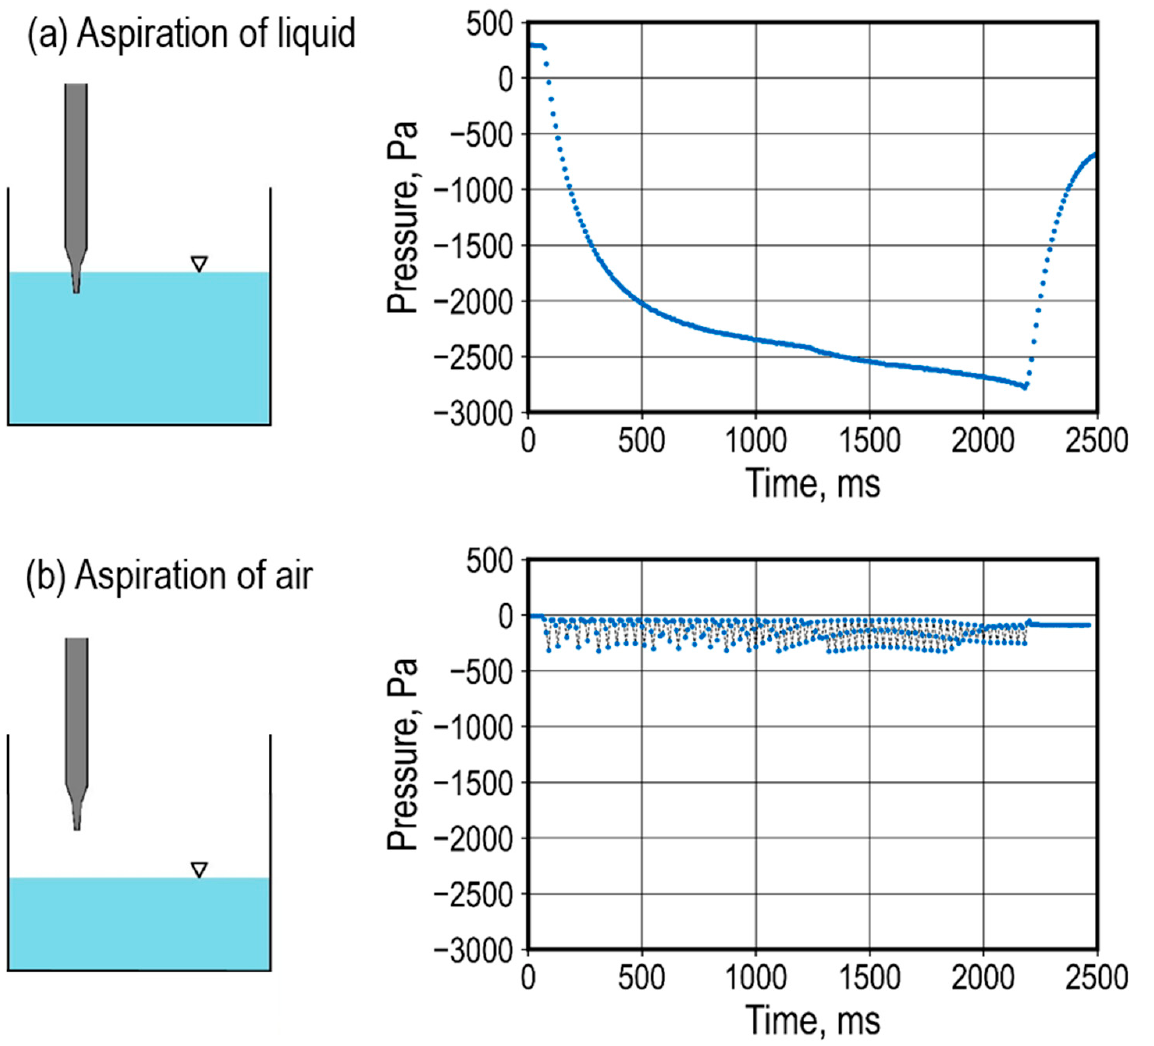
Figure 1. Typical pressure dynamics inside the needles of the LHS during an aspiration step (2200 ms) followed by a dispensing step: ( a ) needle in liquid phase (water), and ( b ) needle in gas phase (air). Both pressure dynamics were recorded with steel needles, which were washed automatically shortly before use.